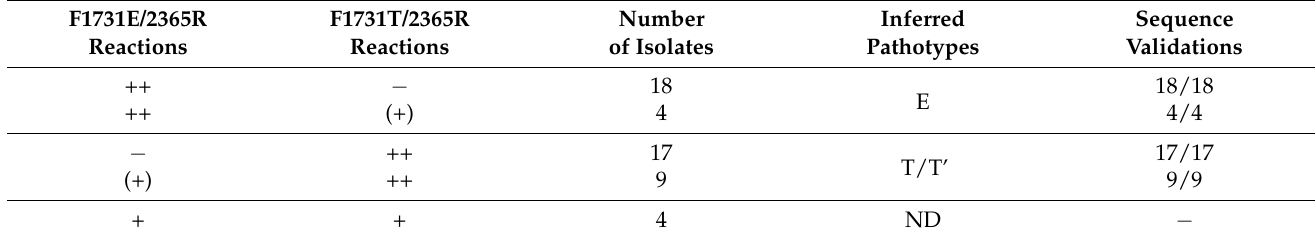
Figure 3. ( Left panel ). Major RT-PCR profiles obtained using F1731E/2365R (lines 2 and 4) and F1731T/2365R (lines 3 and 5) primer pairs in two independent reactions for each RYMV isolate. Line 1, size marker (1kb); lines 2–3, isolate Ma2, profile E; lines 4–5, isolate Ma105, profile T. ( Right panel ). Major RT-PCR profiles obtained using F353T/R4 (lines 2 and 4) and F353G/R4 (lines 3 and 5) primer pairs in two independent reactions for each T/T’ isolate. Line 1, size marker (100 base pairs); lines 2–3, isolate CI2, profile T; lines 4–5, isolate Tg247, profile T’. Table 3. RT-PCR profiles using F1731E/F1731T/2365R primers, deduced E vs. T/T’ pathotypes, and sequence validation of the molecular signature at position 1731–1733 for 49 RYMV isolates. ++, presence of a strong band, +, presence of a band, (+) presence of a feint band, − absence, ND, not determined.